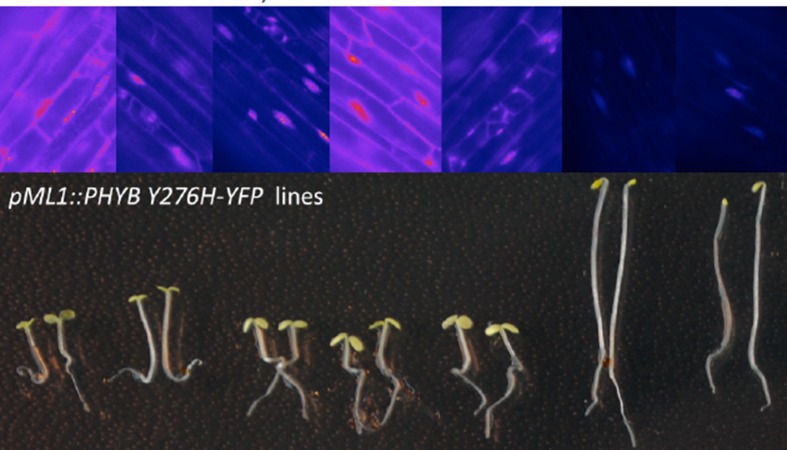
DOI:
http://dx.doi.org/10.7554/eLife.17023.017